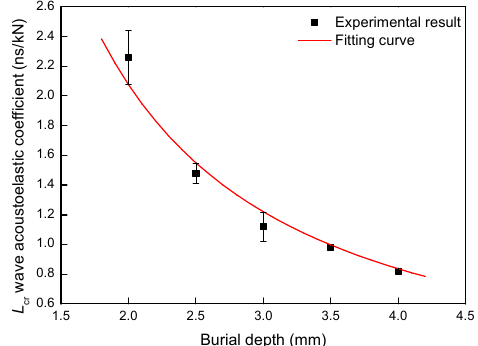
Figure 8. Curve of fitting coefficient and burial depth of slot.